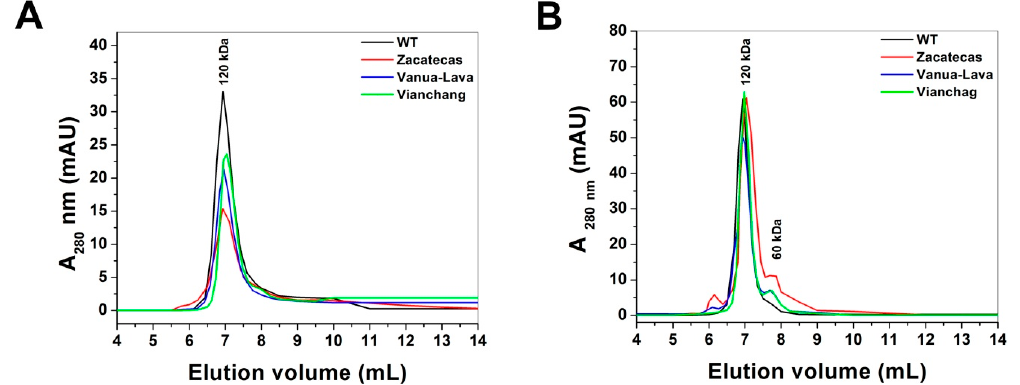
Figure 6. Gel filtration chromatography to evaluate the protein stability of glucose-6-phosphate dehydrogenases (G6PDs). The stability of native G6PDs dimers without ( A ) or with ( B ) Gdn-HCl were tested by FPLC, incubating the enzymes (0.2 mg/mL) at 37 °C for 2 h and then loading them onto a size-exclusion chromatography column. Thirty microliters samples of G6PDs protein solutions were loaded on Shodex Protein ® KW-802.5 column coupled to ÄKTA Primes FPLC system (Amersham Pharmacia Biotech, Piscataway, NJ, USA) previously equilibrated with 50 mM phosphate buffer at pH 7.35; flow rate: 1.0 mL/min.